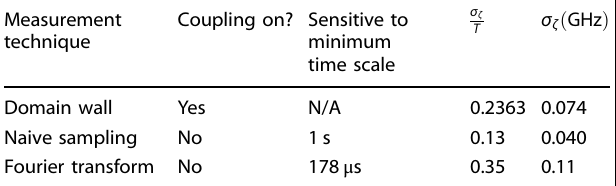
Fig. 8 Difference between domain-wall probability on site i from the probability that domain wall is found on site 5 for two scales fi tting was performed by numerically sampling over disorder of the coupling. Note that background susceptibility corrections realizations and varying the parameter σ ζ until the least squares have not been T